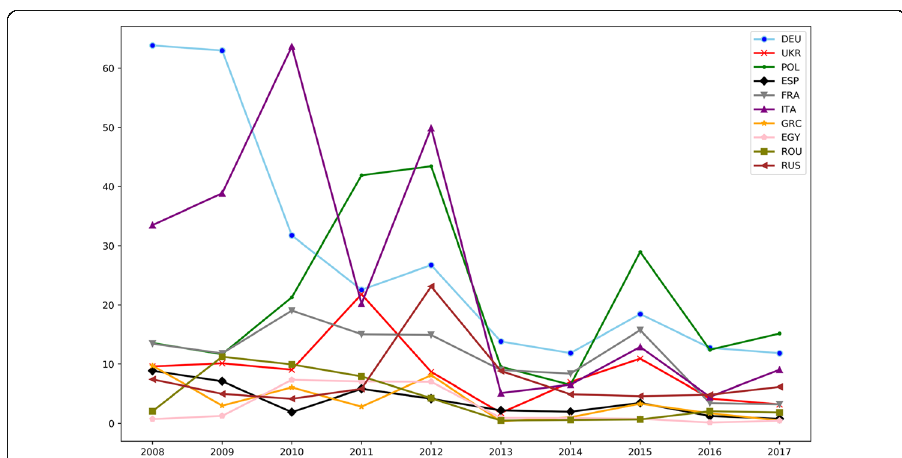
Fig. 9 Betweenness centrality values (main nodes), 2008 – 2017. Note: the graph reports nodes that ranked among the top 10 in the average betweenness centrality over the period 2008 – 2017. To account for the different size of the networks over time, the measure is normalized by dividing the unscaled betweenness centrality of every node by a scaling factor, which is the maximum possible value of the measure in every